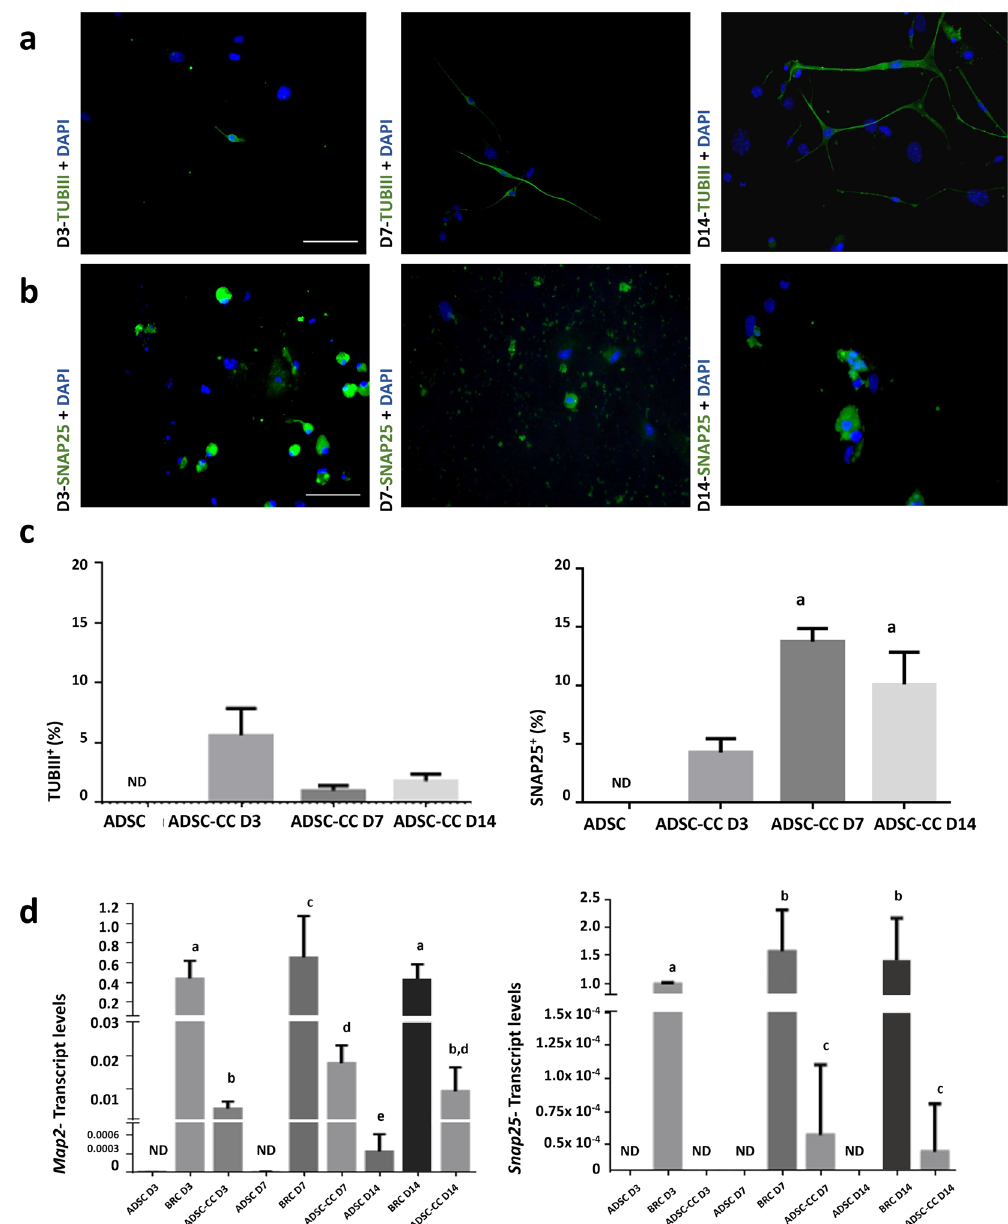
Figure 1. Immunocytochemistry and flow cytometry analysis of SNAP25 and TUBIII, and transcript levels of Map2 and Snap25 . ( a ) SNAP25 + ADSC-CCs on days 3, 7, and 14, indicating the capacity of BRC to induce the differentiation of ADSC when in co-culture. ( b ) TUBIII + ADSC-CCs on days 3, 7, and 14, indicating the capacity of BRC to induce the differentiation of ADSC when in co-culture. ( c ) Graphs show the percentage of positive cells for TUBIII (left) and for SNAP25 (right) on days 3, 7 and 14. ( d ) Graph on the left shows transcript levels of Map2 , demonstrating an increase on day 7 compared to day 3 and graph on the right shows transcript levels of Snap25 , demonstrating an increase on day 7 compared to day 3. TUBIII- beta tubulin III; SNAP25- synaptosomal-associated protein 25. Map2- microtubule-associated protein 2. Different letters indicate p < 0.05. Graph bars correspond to standard error. Bar = 100 µ